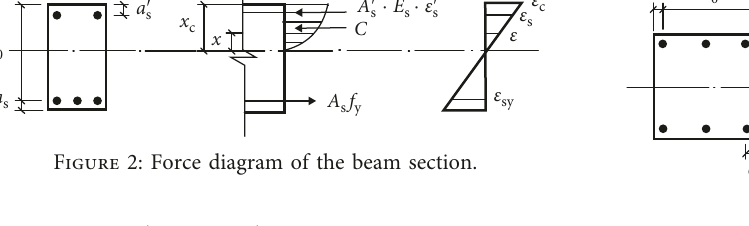
Figure 3: Force diagram of the column section.